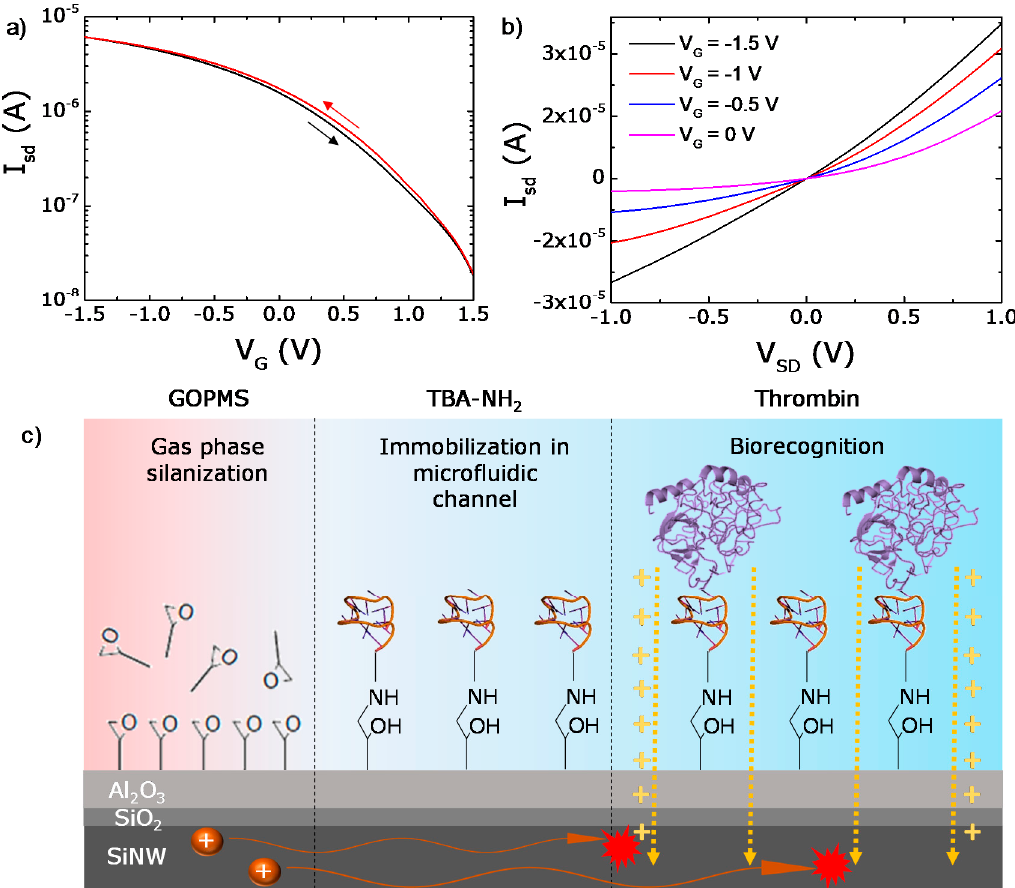
Figure 2. ( a ) Semi logarithmic transfer characteristics and ( b ) output characteristics of the Si NW FETs. ( c ) Biochemical functionalization of the aluminum oxide surface. Glycidoxypropyltrimethoxysilane (GOPMS) was used as a linker molecule to covalently attach the aptamer via amino-alcohol bond formation. The further thrombin recognition by the aptamer leads to semiconducting channel modulation (dashed yellow arrows).